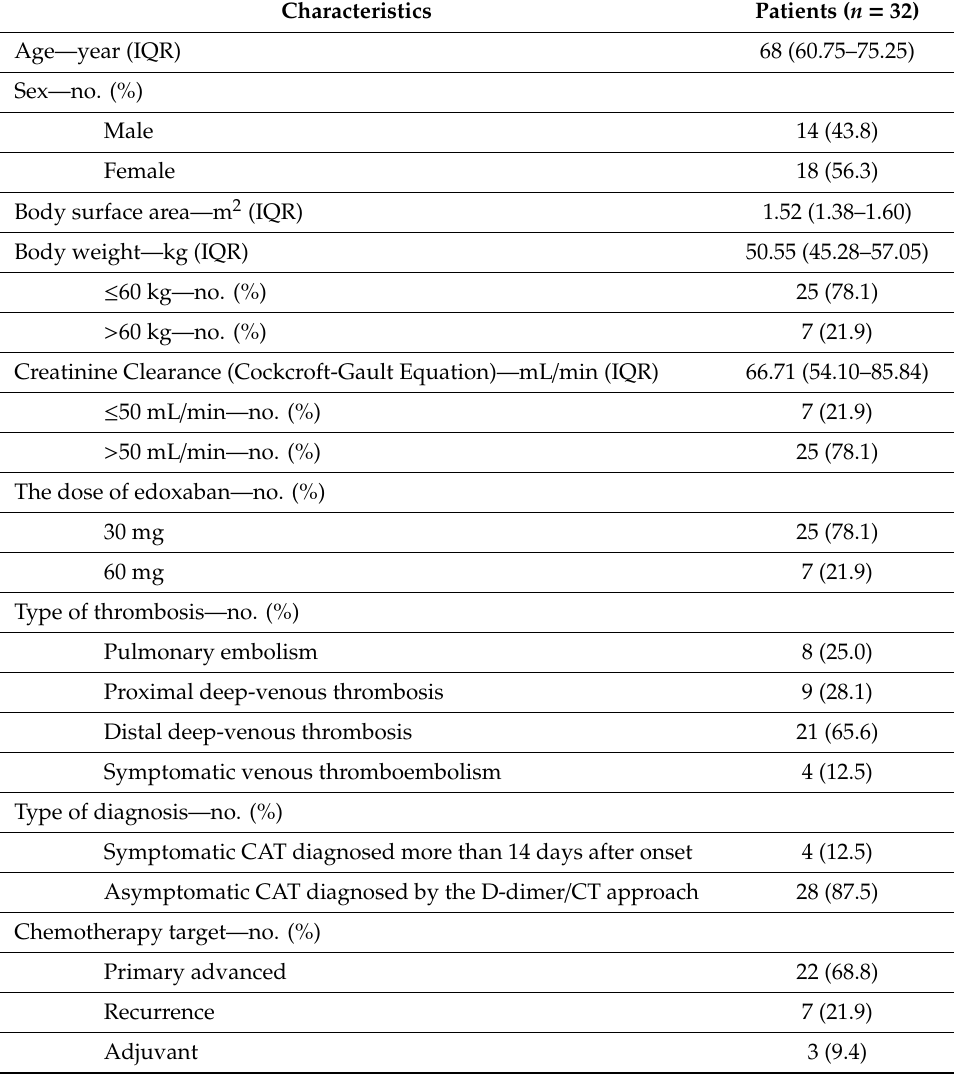
Table 1. Demographic and baseline characteristics of patients ( n =